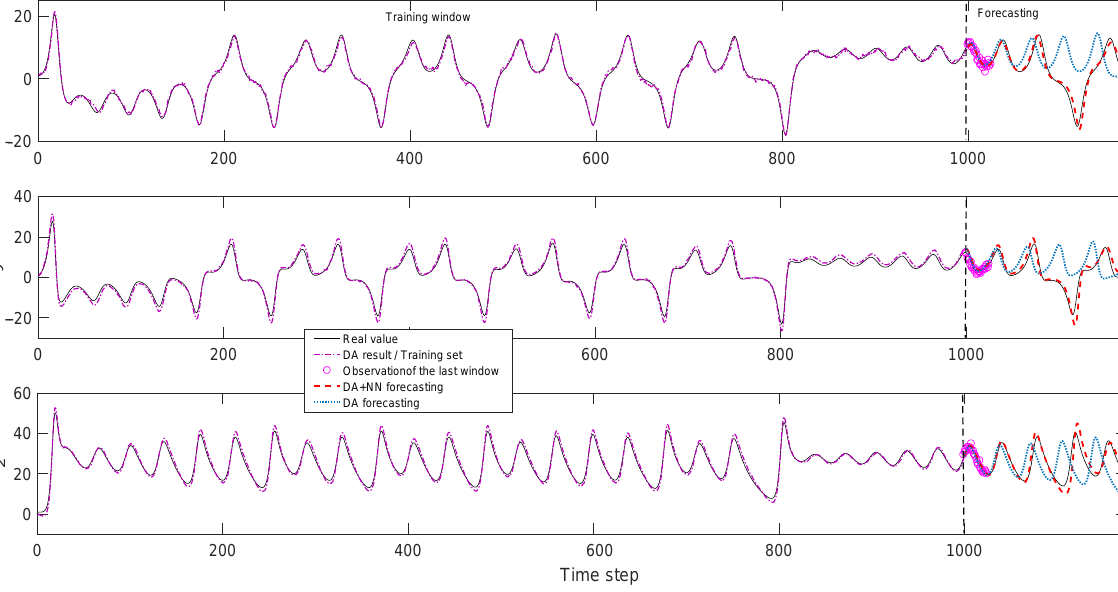
(a) Trajectories of the 4D-Var and DA with neural network on three axes.